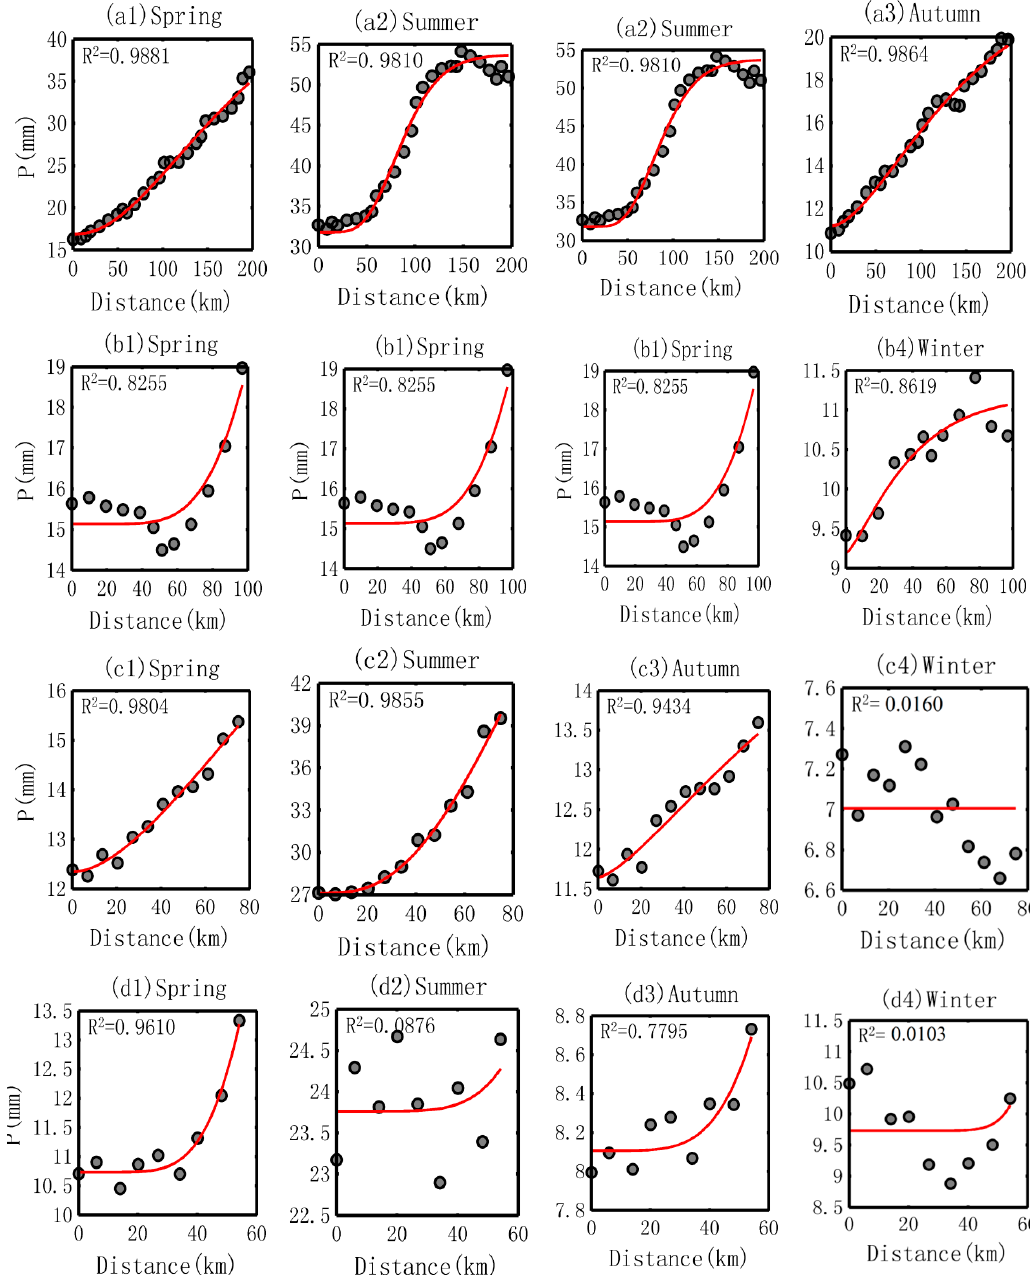
Figure 7. Performance of the information entropy based model at seasonal scale: ( a ) Kashi Oasis located in the western basin; ( b ) Akesu Oasis located in the northern basin; ( c ) Kuerle Oasis in the northeast basin; and ( d ) Hetian Oasis in the southwestern basin.